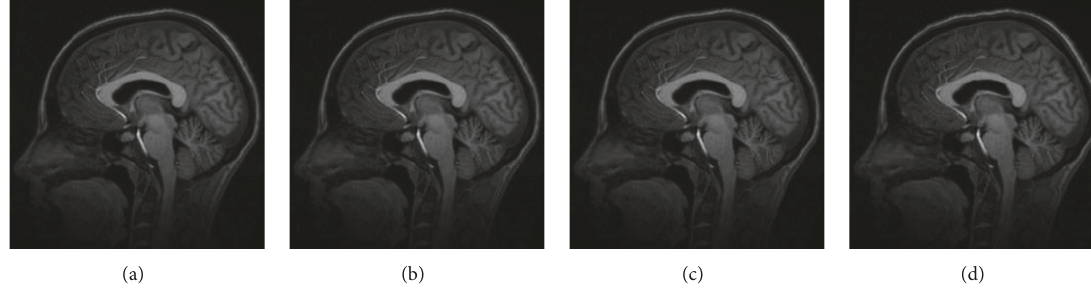
Figure 5: Registration result. (a) Our method, (b) diffeomorphic demons, (c) additive demons, and (d) active